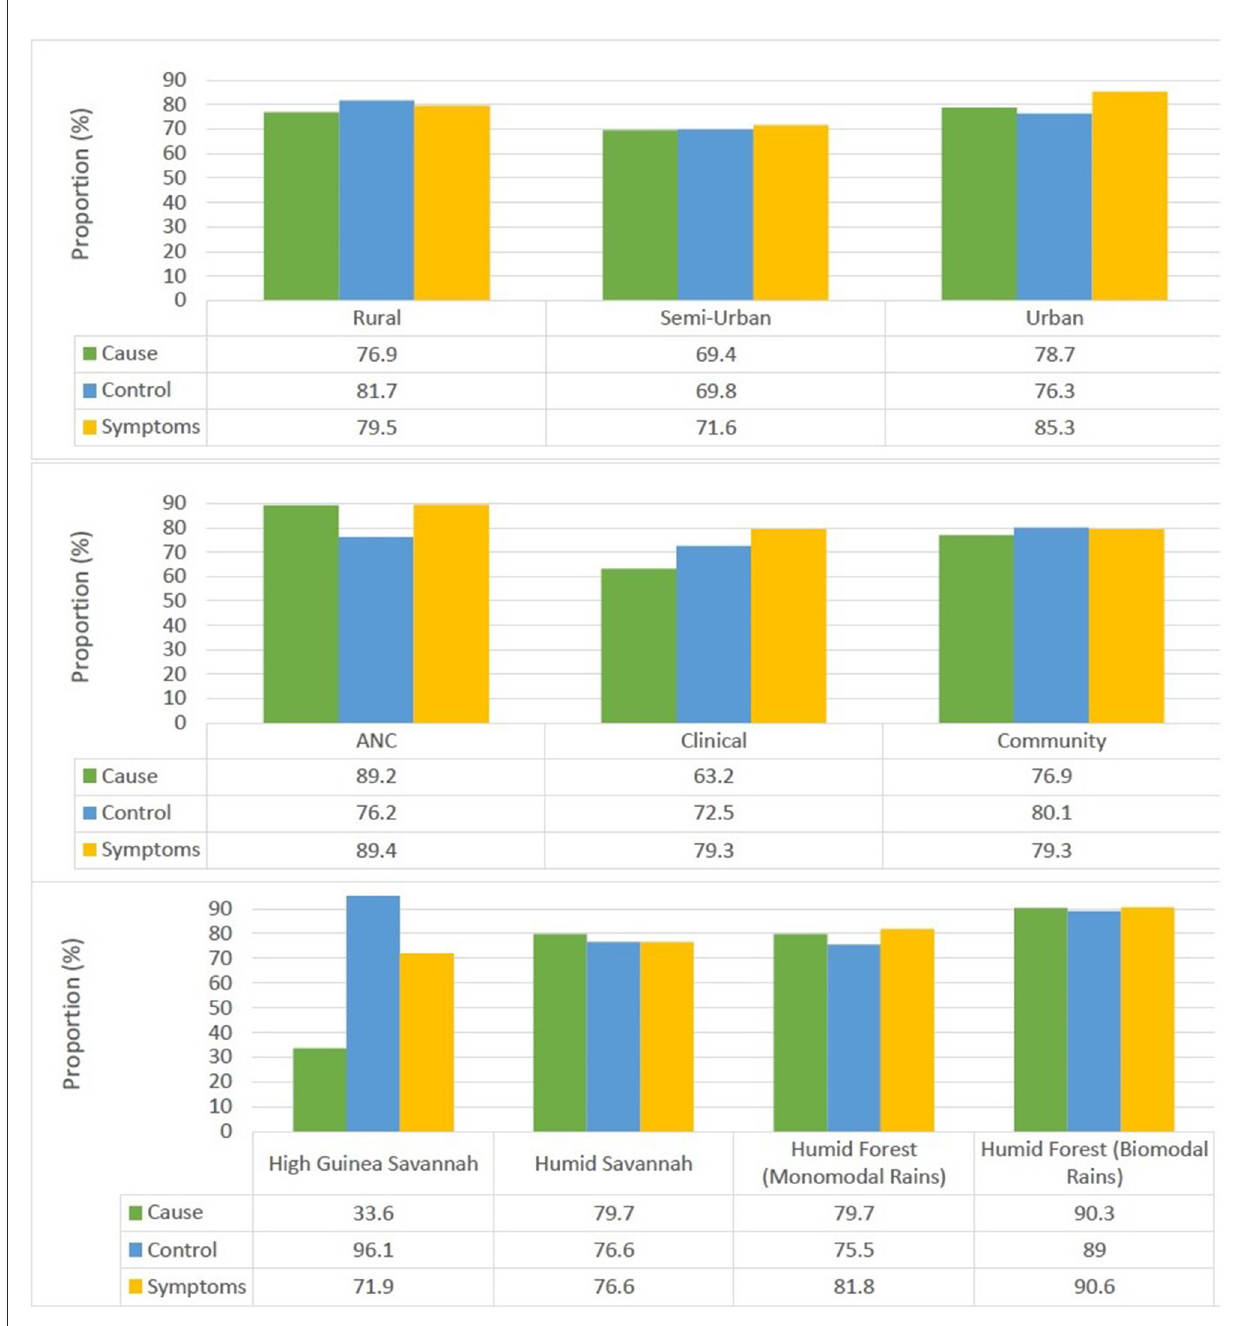
FIGURE2 Knowledge of the cause, control measures, and symptoms of malaria in Cameroon.